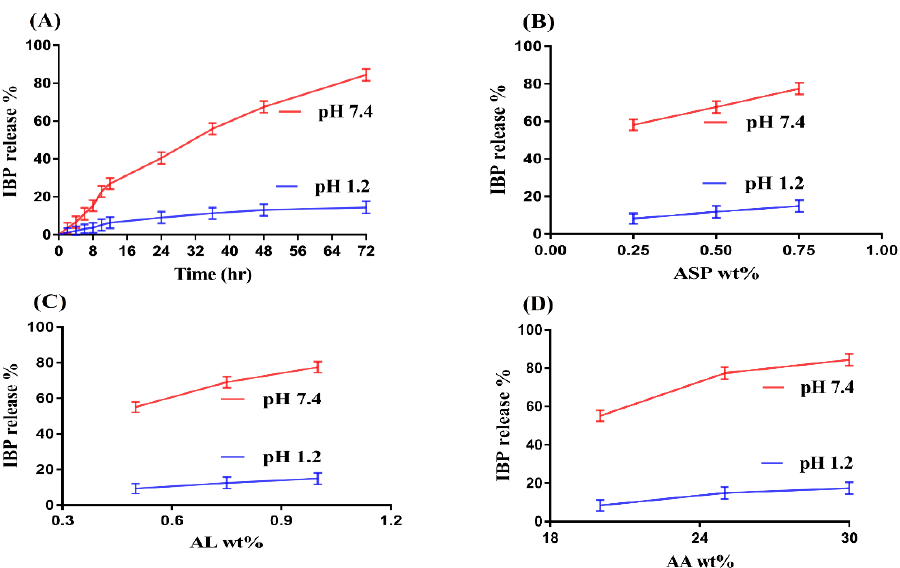
Figure 2. Effect of ( A ) pH, ( B ) Aspartic acid (ASP), ( C ) Alginate (AL), and ( D ) Acrylic acid (AA) on IBP release percent from ASP/ALPAA hydrogels.